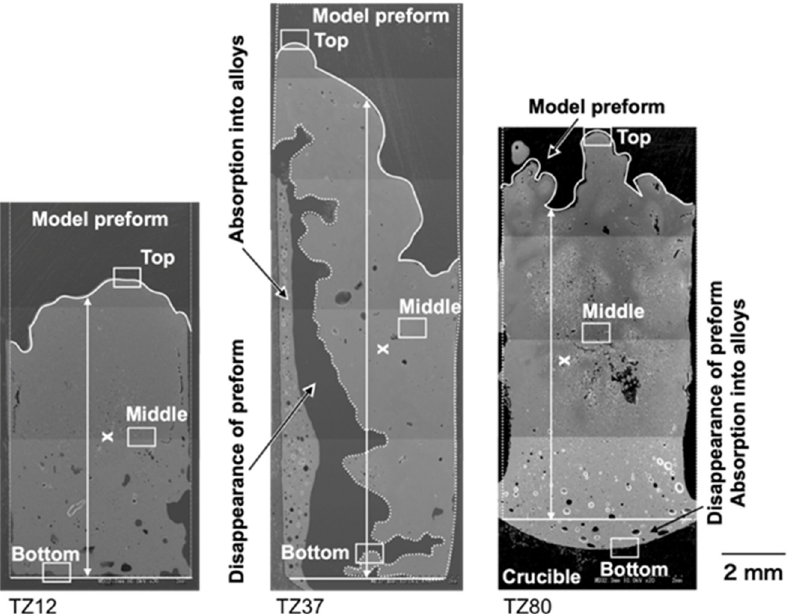
Figure 4. Macroscopic SEM images of infiltrated model preforms. Here, “×” represents the infiltration height.